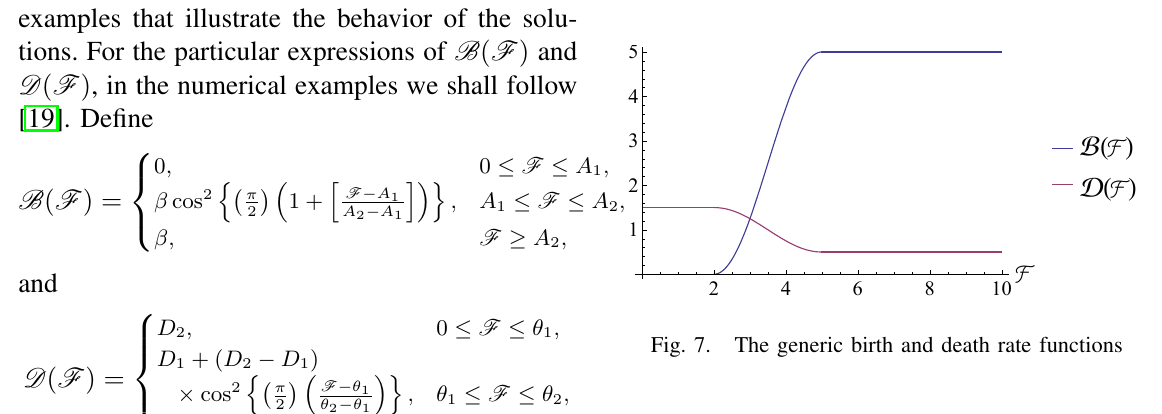
Fig. 6. Nullclines for the model (4) in the case of two unstable internal equilibria; the thick dashed line denotes the stable manifold of the saddle point E 2 .